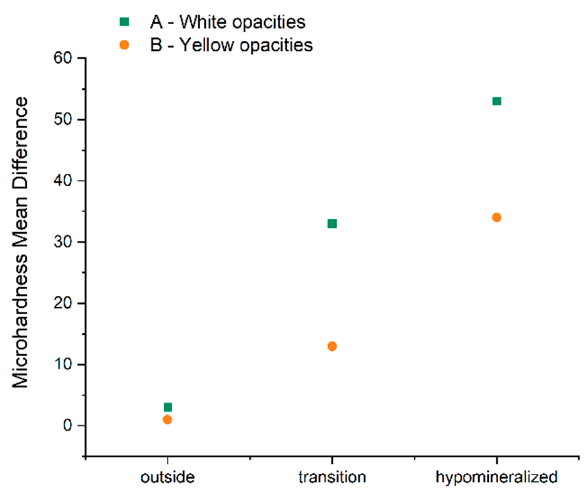
Figure 5. Plot of the mean microhardness differences pre- and post-treatment by region in A—white opacities group—and B—yellow opacities group.